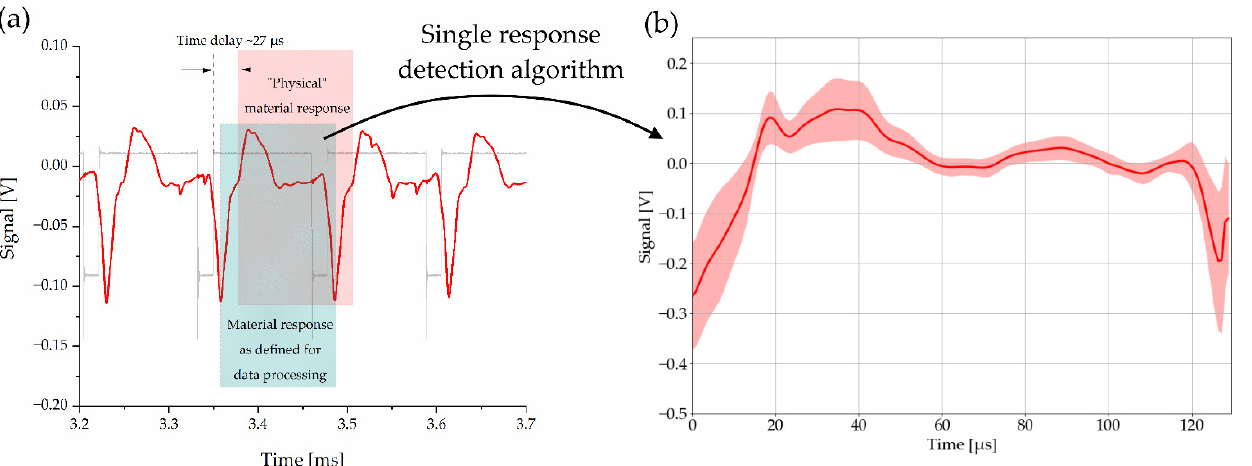
Figure 3. Signals recorded by the oscilloscope during one data-acquisition step ( a ): a laser-pulse salvo ( grey ) consisting of M (default: M = 300) single pulses lead to an acoustic response of the material ( red ). The zoom in ( b ) reveals single laser pulses (default length = 110 µs), each